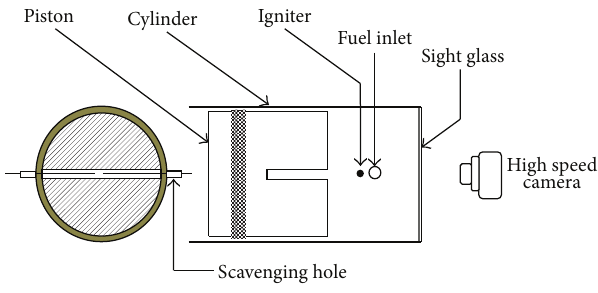
Figure 1: Experimental setup.